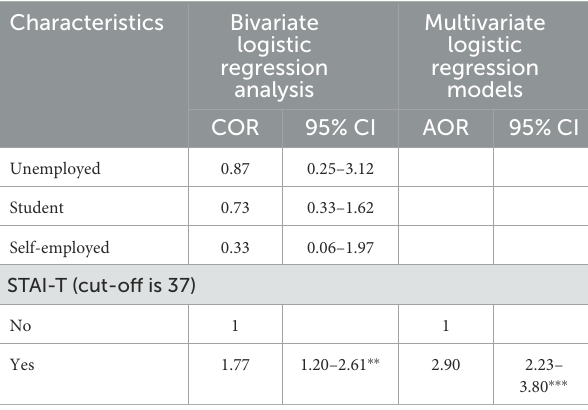
in the family, having another chronic disease, marital status, and depression among patients with cancer were significant factors of anxiety traits. These essential and significant factors were analyzed relative to traits of anxiety disorders using the stepwise forward model of multivariate logistic regression models and then